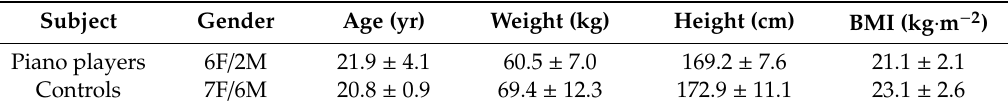
Table 1. Relevant participant demographics for piano players and controls.